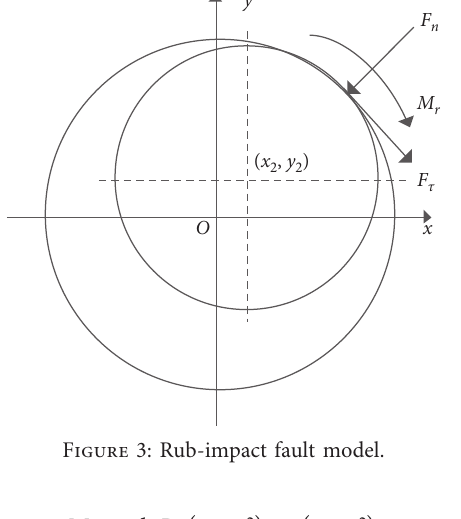
Figure 3: Rub-impact fault